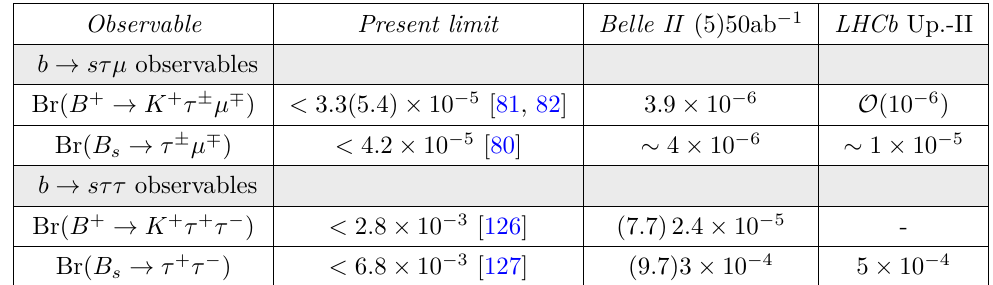
Table 6 . Future Belle II and LHCb sensitivities, at 95% C.L., for b → sτµ and b → sττ observables.